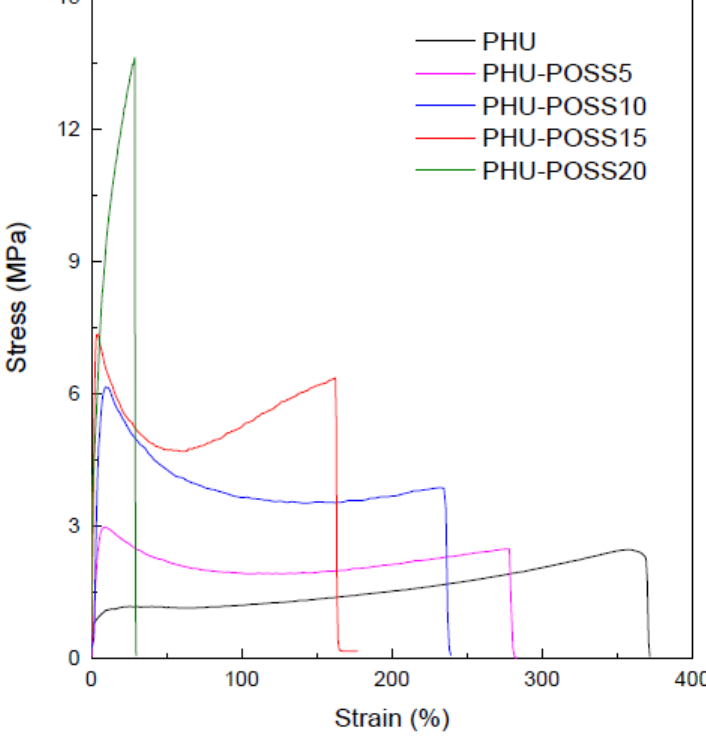
Figure 9. Stress-strain curves of PHU and PHU-POSS nanocomposites. Table 1. Thermal and mechanical properties of PHU and PHU-POSS